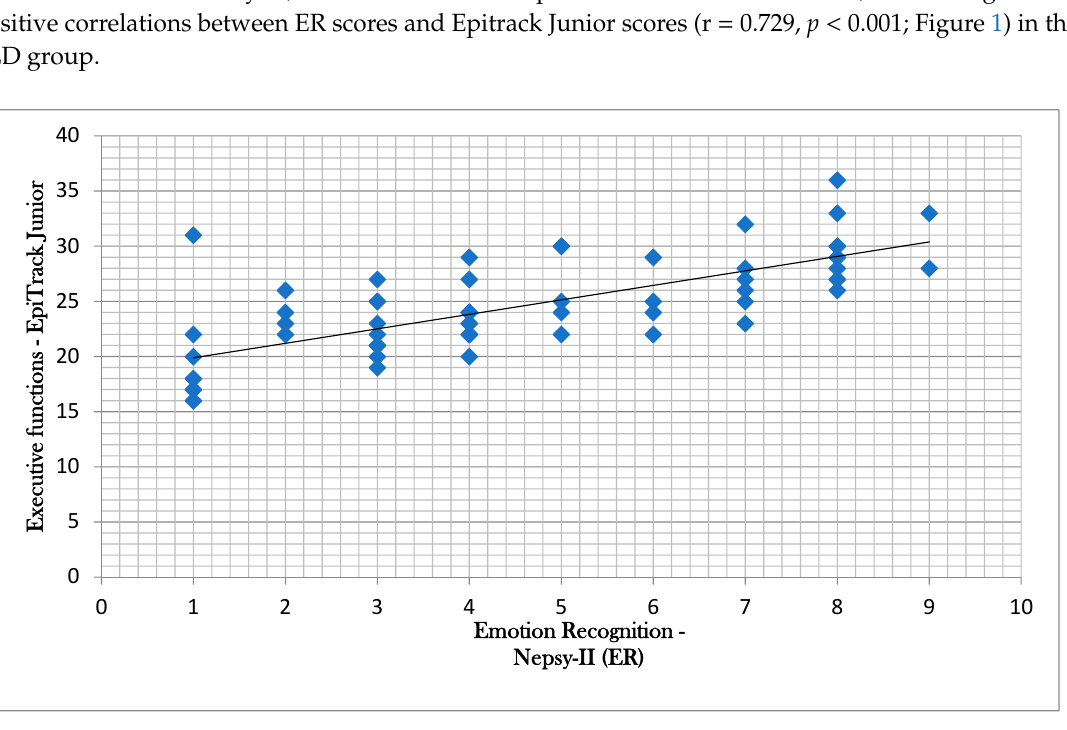
Table 2 resumed all neuropsychological mean scores for the NEPSY-II, WISC-IV, and EpiTrack Junior in two groups, and the results of statistical comparison.